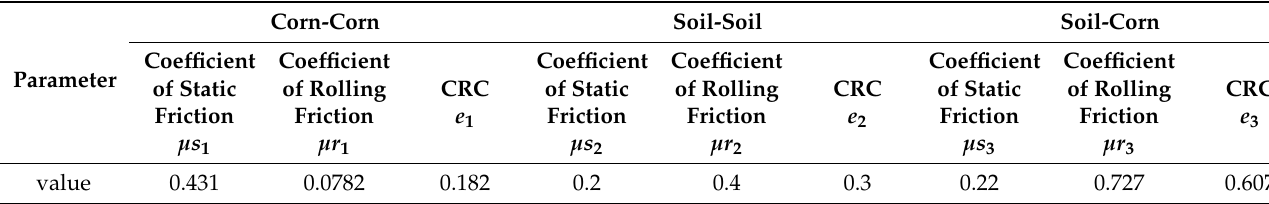
Table 3. Discrete element simulation contact parameters of corn seed and soil.